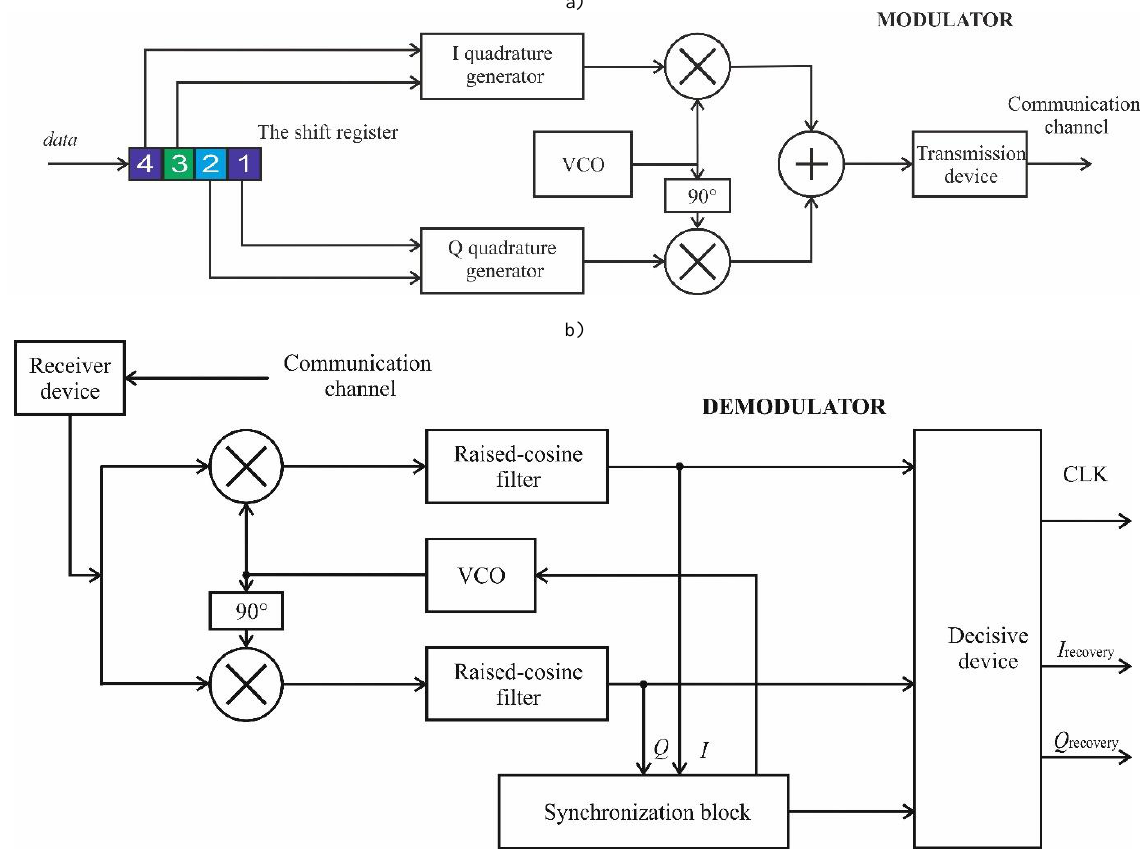
Fig. 3. Generalized functional diagram of a typical QPSK modem: a) modulator, b)